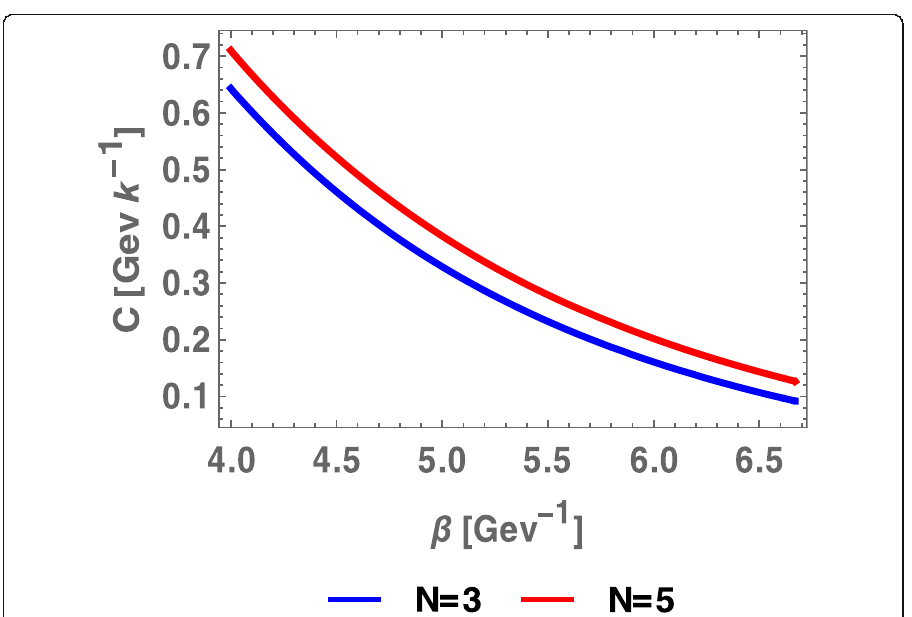
Fig. 6 Specific heat C is plotted against β for different values of N